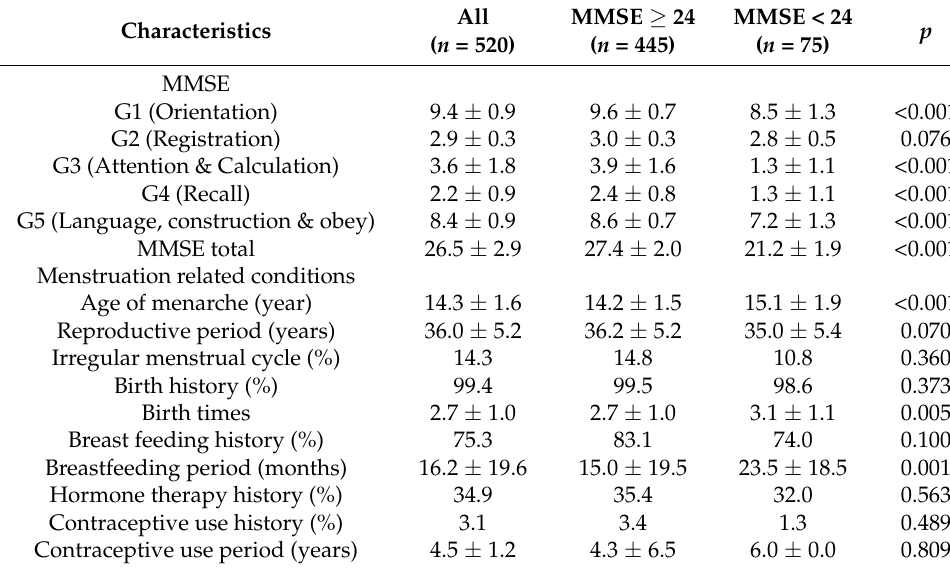
Table 2. Comparison of MMSE and MMSE subscores and female menstruation related conditions among participants according to total MMSE scores ≥ 24 or < 24.